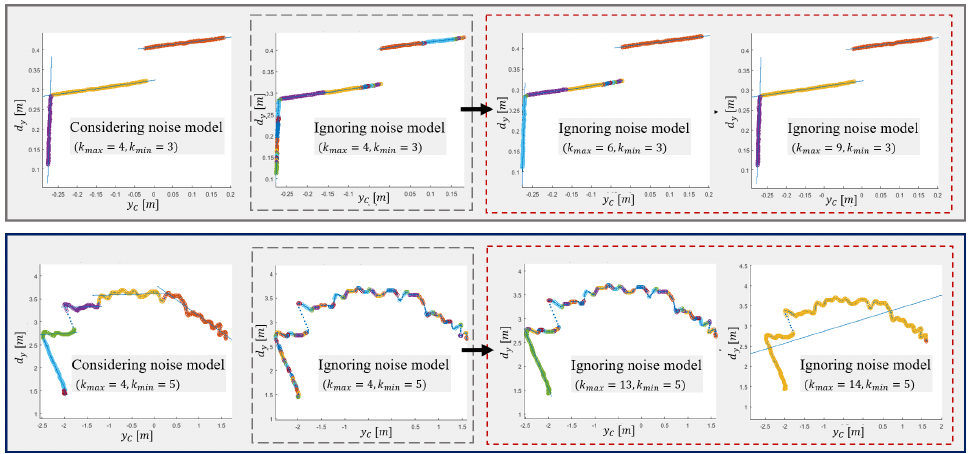
Figure 15. Line segment detection on real data acquired with D435i. Two examples showing how taking noise into account reduces over-segmentation and the possibility of incorrect clustering by reducing an increase in k max . In dashed rectangles the results when disregarding modelled noise during segmentation are shown. Based on the results in the red rectangles, we can conclude that in the case of using a depth camera, we can ignore quadratic noise behavior at smaller distances, where over-segmentation is reduced by increasing k max , but it can fail at larger ones due to its significant